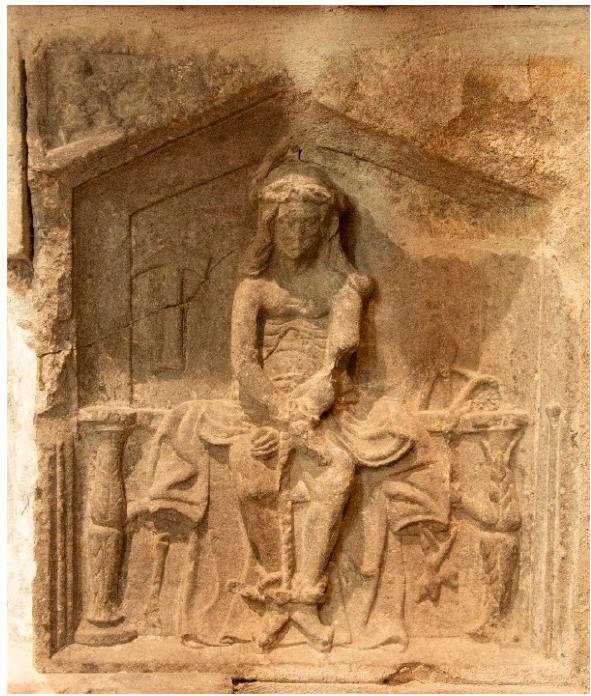
Figure 34. Ecce Homo , tomb of Bishop Walter Wellesley, formerly at Great Connell, now at St Brigid’s Cathedral, Co. Kildare, c.1539. Photograph by the author.